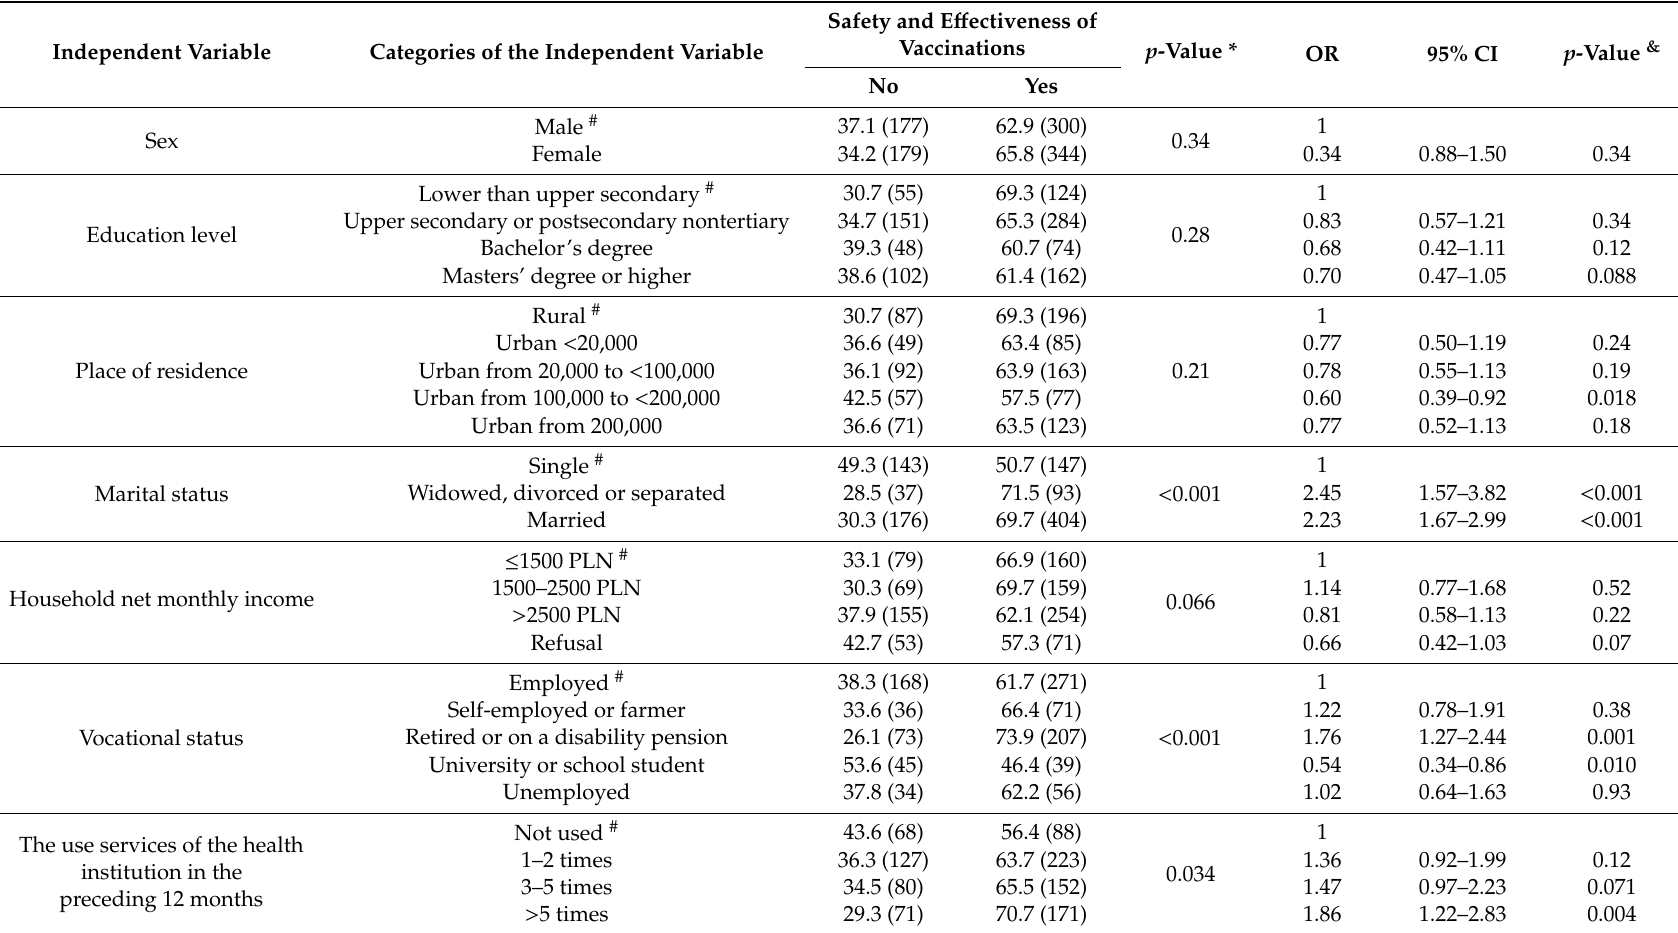
Table 2. The determinants of the opinion about the safety and e ff ectiveness of vaccinations.